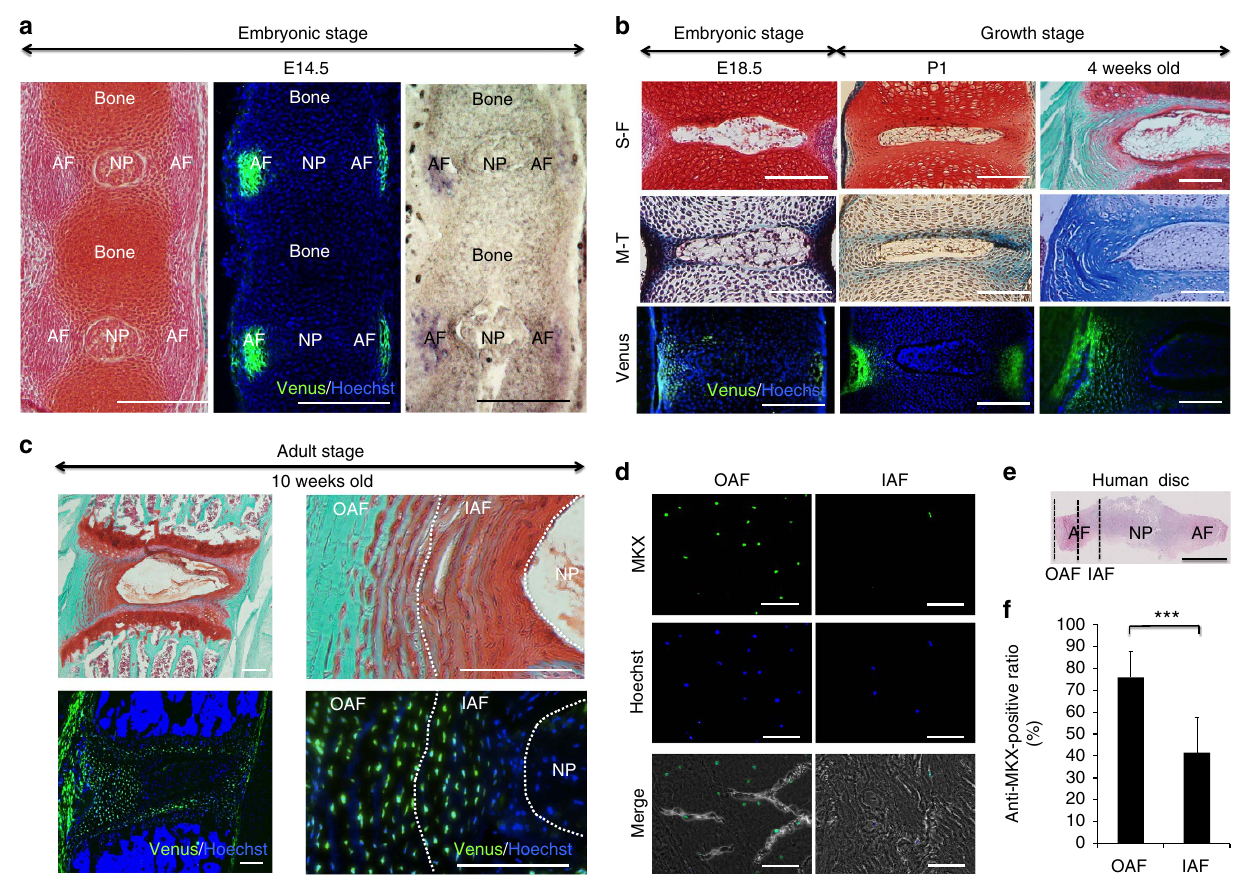
Figure 1 | Mohawk gene (Mkx) is expressed in the outer annulus fibrosus (OAF). ( a ) Representative images of intervertebral discs (IVDs) of E14.5 mice. Left: Safranin O fast green stain in a wild-type mouse. Middle: IHC of a Venus knock-in mouse. Green: anti-GFP. Blue: Hoechst. Right: in situ hybridization of Mkx of a Venus knock-in mouse. Scale bars, 200 m m. ( b ) Representative disc images from embryonic stages to growth stages (upper and middle panels, Safranin O fast green (S-F) stain and Masson’s trichrome (M-T) stain in a wild-type mouse; lower panel, IHC of a Venus knock-in mouse; green, anti-GFP; blue; Hoechst). Scale bars, 200 m m. ( c ) Representative images of IVDs from 10-week-old mice (upper panel, safranin O fast green stain in a wild-type mouse; lower panel, IHC of a Venus knock-in mouse; green; anti-GFP; blue; Hoechst). Scale bars, 200 m m. ( d ) Immunohistochemistry of the coronal sections of a human lumbar disc IAF and OAF (#1: 20-year-old male, L1/2). Green: anti-MKX. Blue: Hoechst. Scale bars, 100 m m. ( e ) Overview of the observed area of the IAF and OAF. The section is a haematoxylin–eosin staining of a human lumbar disc (#1: 20-year-old male, L1/2). Dotted lines indicate borders of the NP, IAF and OAF. Scale bar, 1cm. ( f ) Percentages of human IAF and OAF cells that were positive for MKX in each zone. Values are the mean of nine discs from five donors. Error bars represent s.e.m. *** P o 0.001. Statistical differences were assessed with Student’s t -test. GFP, green fluorescent protein; MKX, Mohawk homeobox protein; P1, postnatal day